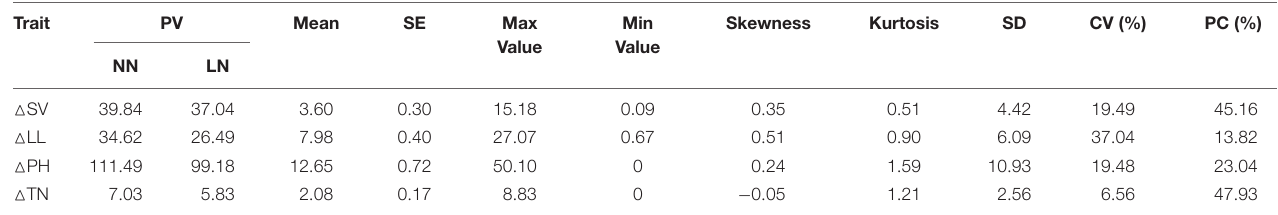
TABLE 2 | Phenotypic differences in the four nitrogen-use efficiency (NUE)-related traits.